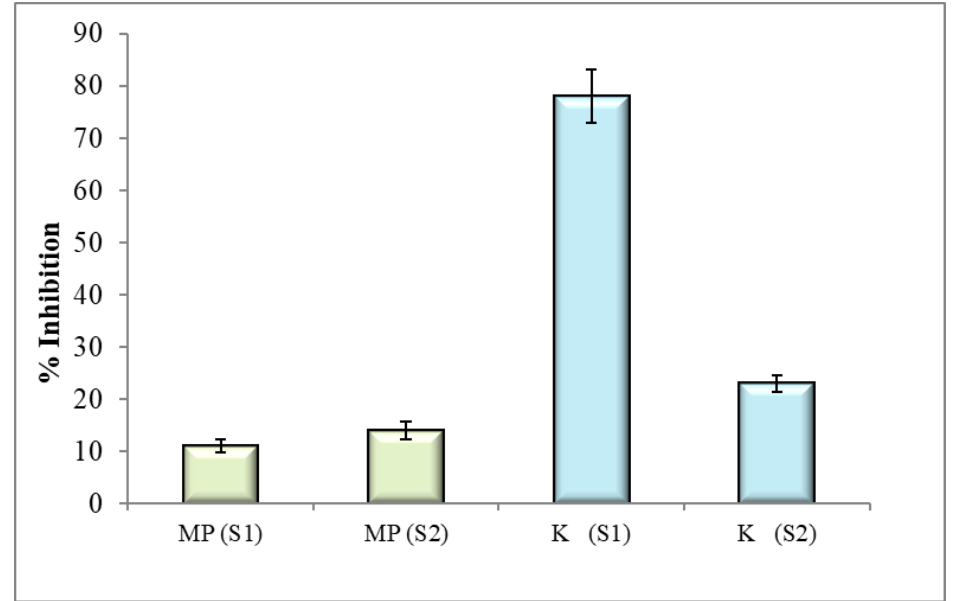
Figure 6. Percentage inhibition of Aliivibrio fischeri after exposure in water samples collected during different time periods (S1 and S2) from Mikri Prespa (MP) and Kastoria (K) lakes.